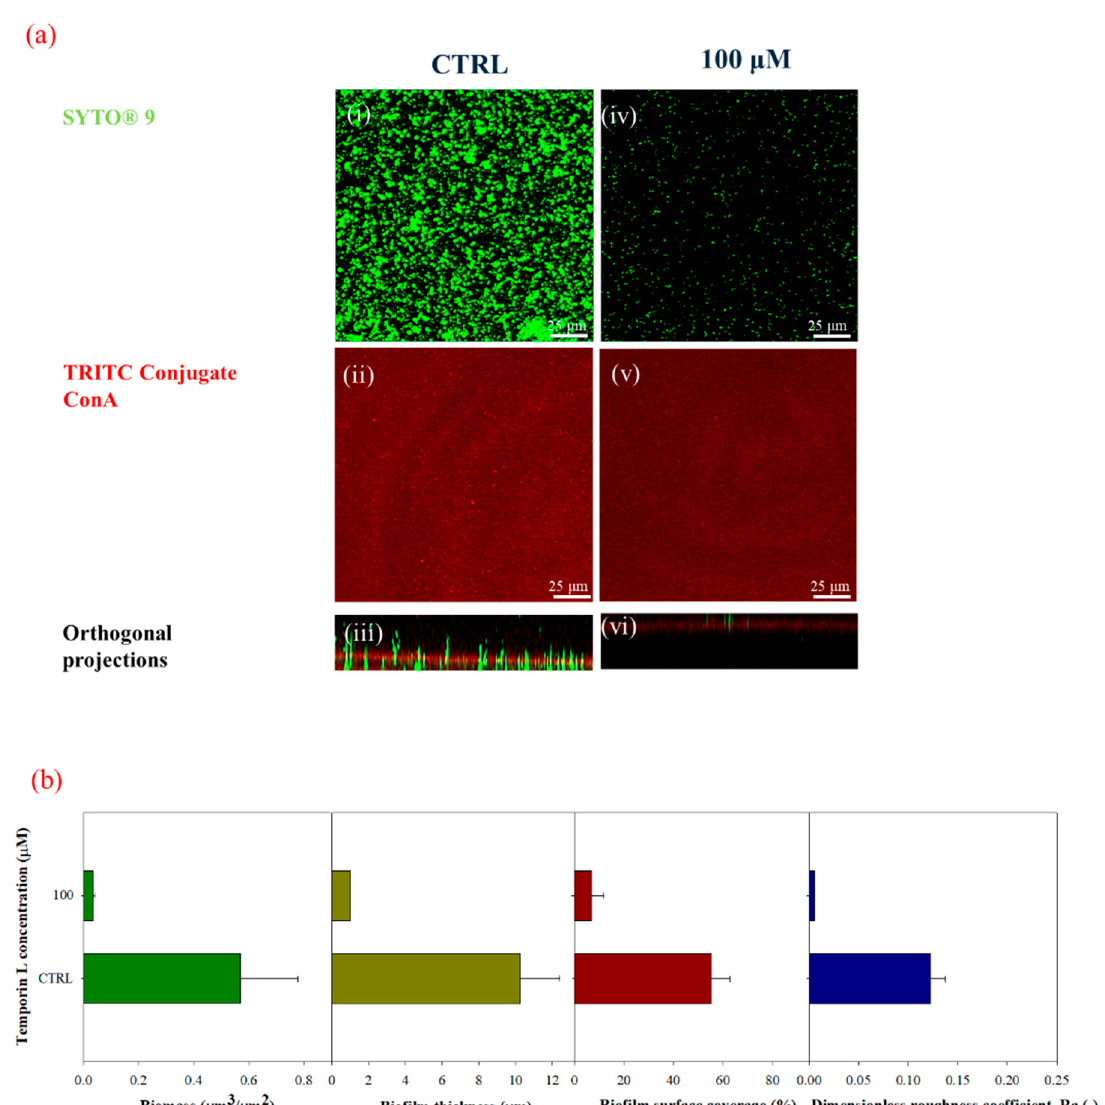
Figure 5. ( a ) CLSM images of biofilms cultivated under in flow conditions in green (i,iv, SYTO ® 9stain at the concentration of, 3 µ L / mL) red channels (ii,v TRITC ConA staining, 100 µ g / mL) and